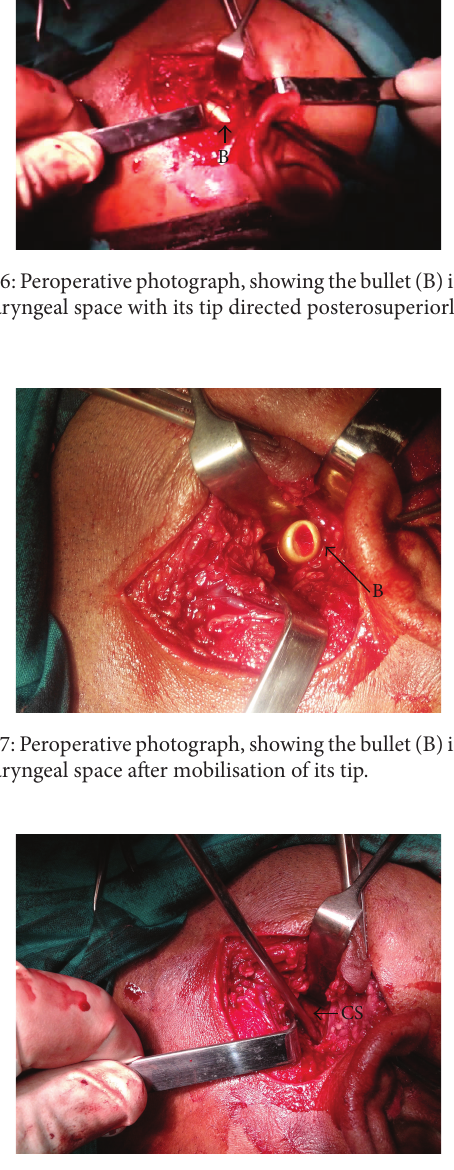
Figure8:Peroperativephotographofthecavitycreatedbythebullet with exposure of the carotid sheath (CS).